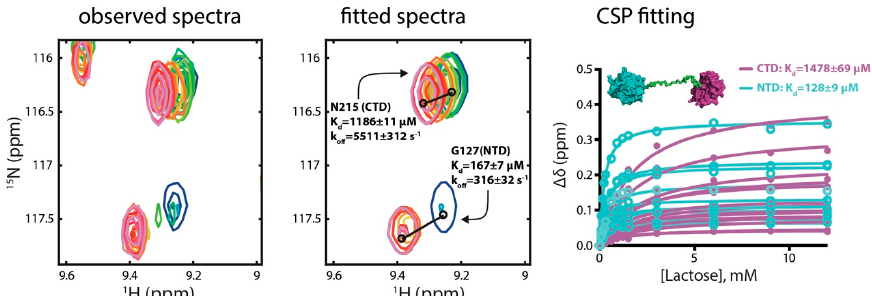
Figure 3. NMR titration of lactose binding to hGal8 full as a tandem-repeat construct. The expanded view of the 2D NMR spectra of hGal8 full is shown in the left panel, and 15 N- 1 H cross peaks corresponding to G127 (NTD) and N215 (CTD) are colour-ramped from red to blue with increasing lactose concentration. The fitted spectra from the TITAN program are overlaid (in the same colouring scheme as the observed spectra) and shown in the middle panel. The lactose K d derived from the TITAN fitting are indicated. The global fitting result of the CSPs as a function of lactose concentration is shown in the right panel. The titration curves of residues that corresponded to the NTD and CTD are coloured in cyan and magenta, respectively.